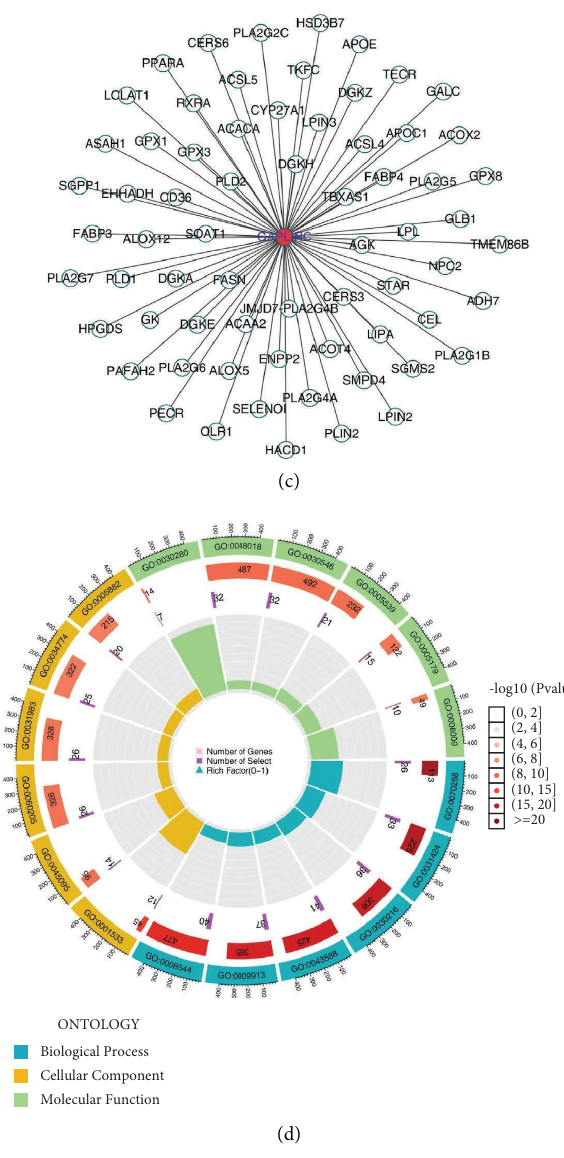
Figure 8: GAPLINC may afect M2 macrophages’ polarization through multiple metabolism pathways. (a) Metabolism diferences in patients with high and low GAPLINC expression; (b) metabolism diferences in patients with high and low M2 macrophage infltration; (c) GAPLINC afects tumor metabolism and M2 macrophages by regulating specifc molecules; (d) GO analysis of